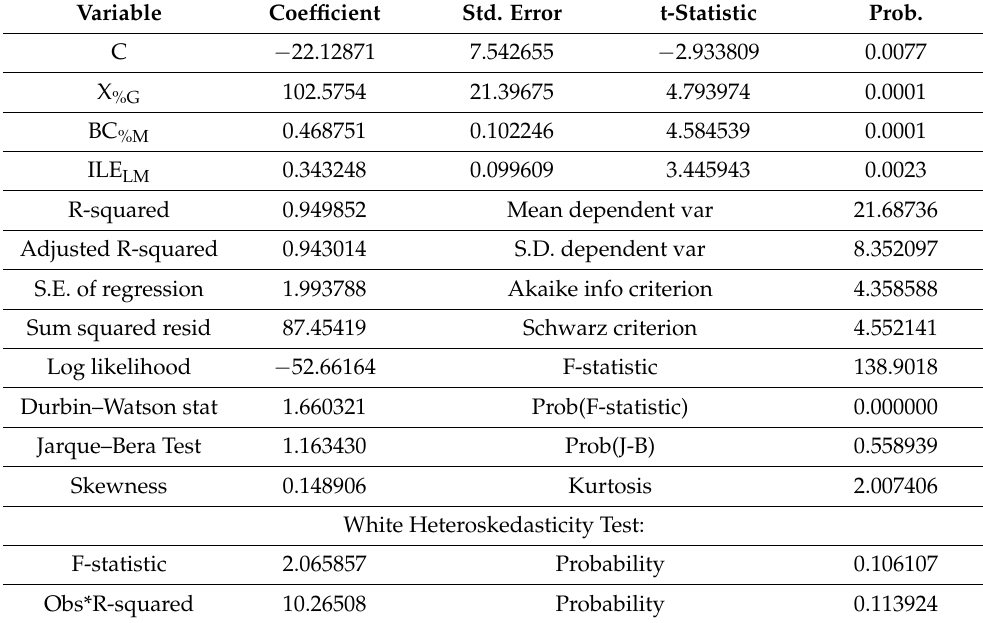
Table 11. S FDI_in(%GDP) model by X %G , BC %M and ILE LM for SL.